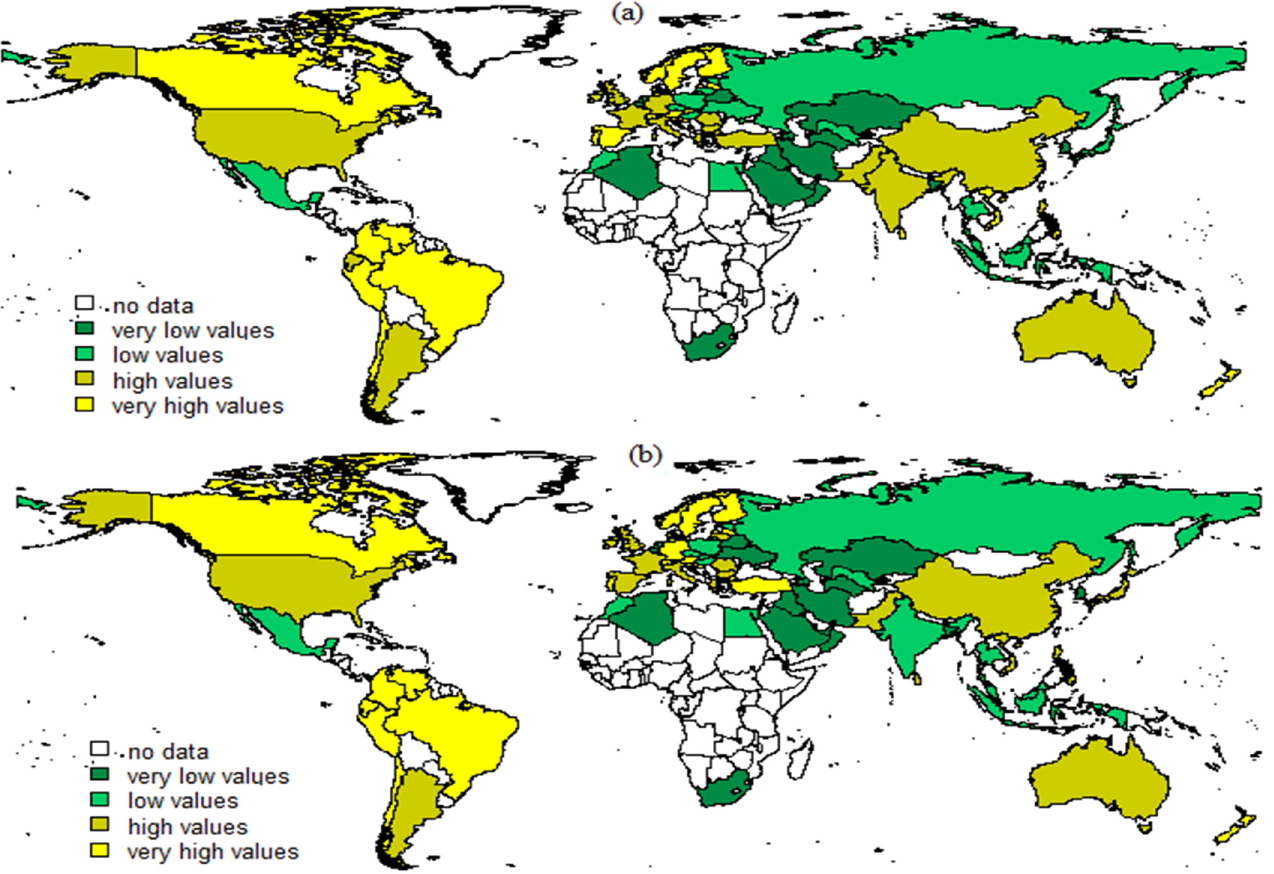
Figure 2. Spatial distribution of the share of energy from renewable sources in total energy consumption in ( a ) 2013 and ( b ) 2019.